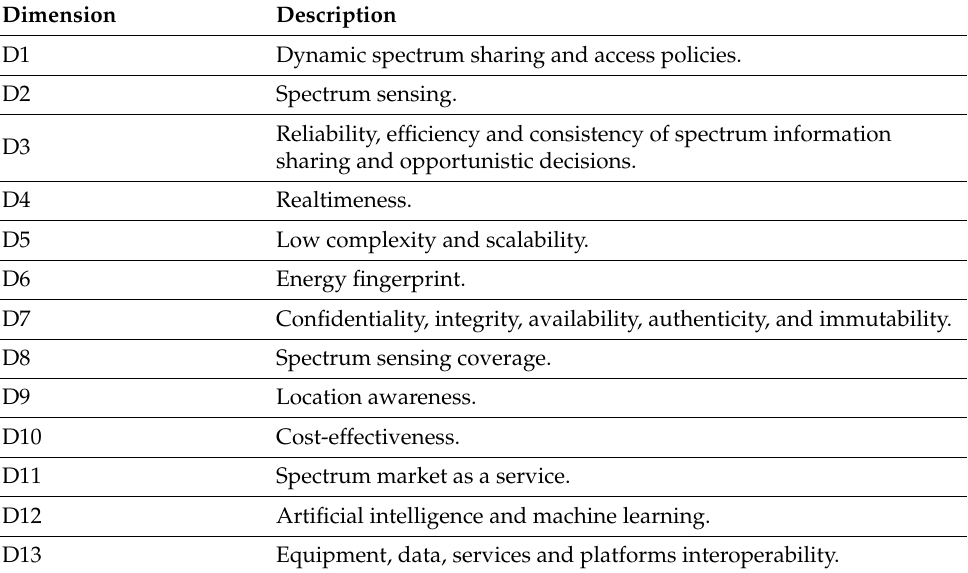
Table 1. Design dimensions considered in this